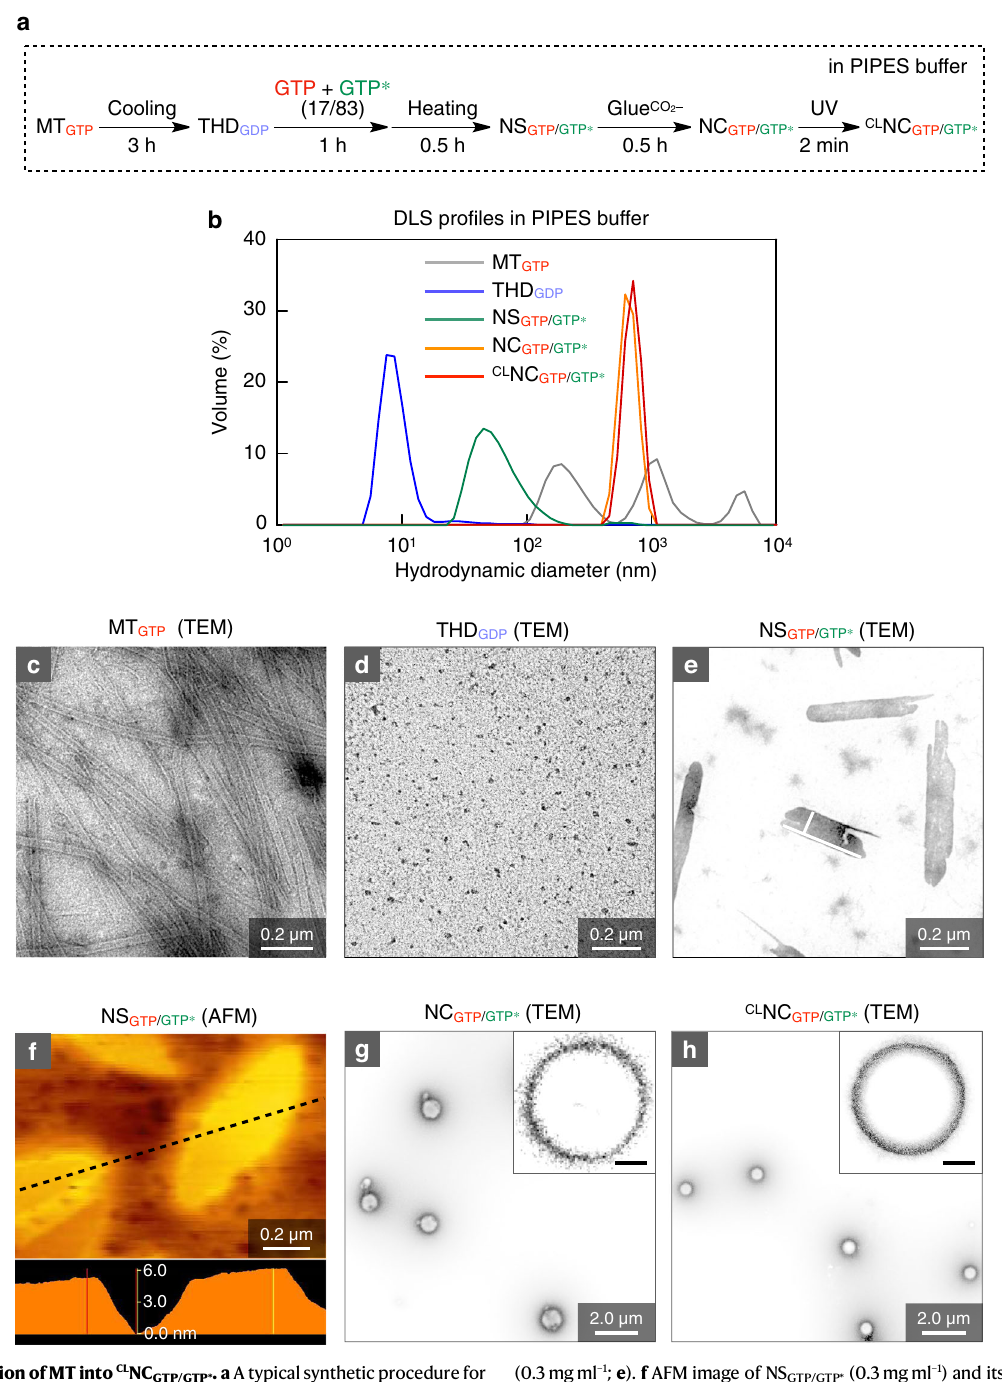
(0.3mgml – 1 ; e ). f AFM image of NS GTP/GTP* (0.3mgml – 1 ) and its height pro fi le. g , h TEMimagesofNC GTP/GTP* (13 µ gml – 1 ; g )and CL NC GTP/GTP* (13 µ gml – 1 ; h ).AllTEM samples were negatively stained with uranyl acetate. Inset scale bars,